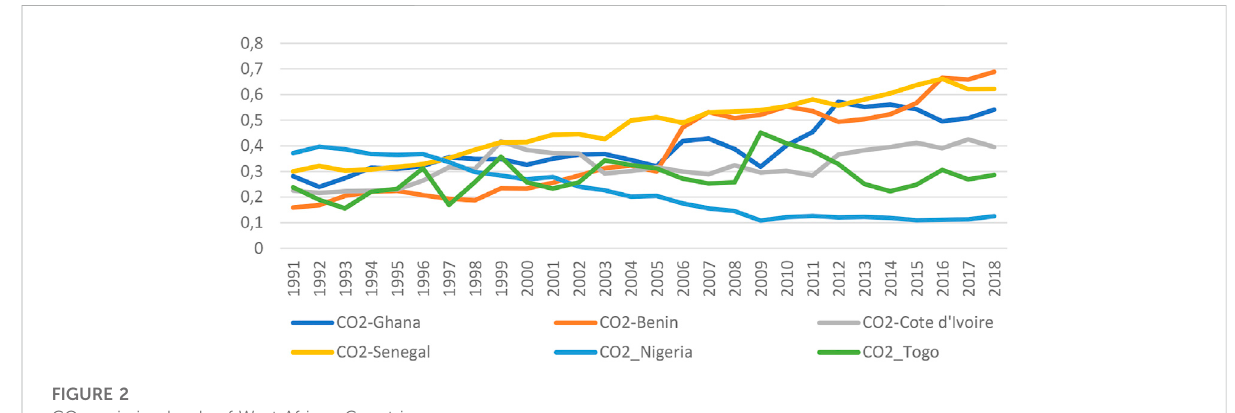
FIGURE 2 CO 2 emission levels of West African Countries.